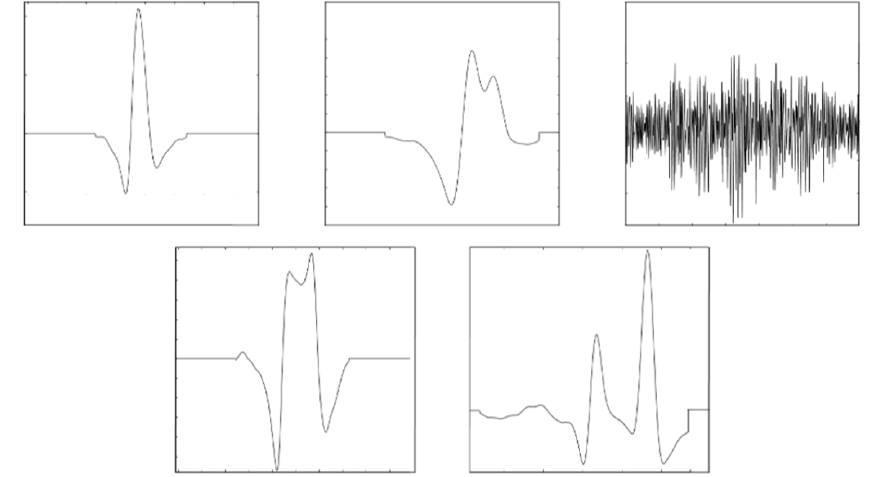
Figure 15. The simulated artefacts.